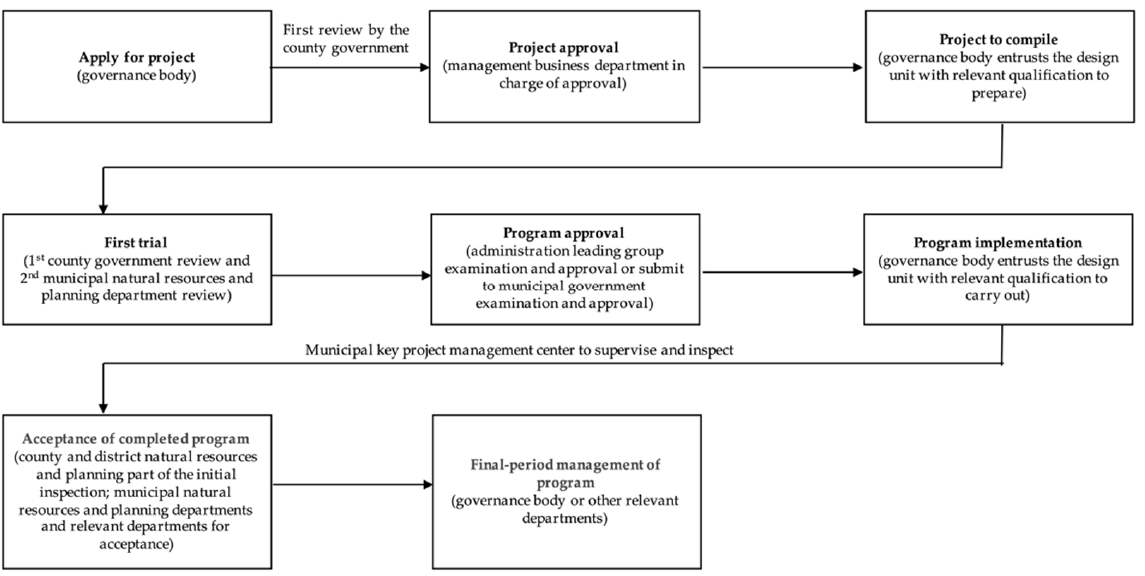
Figure 7. Flow chart of construction of ecological restoration and control project in subsidence area. Source: organized by the authors according to research data.